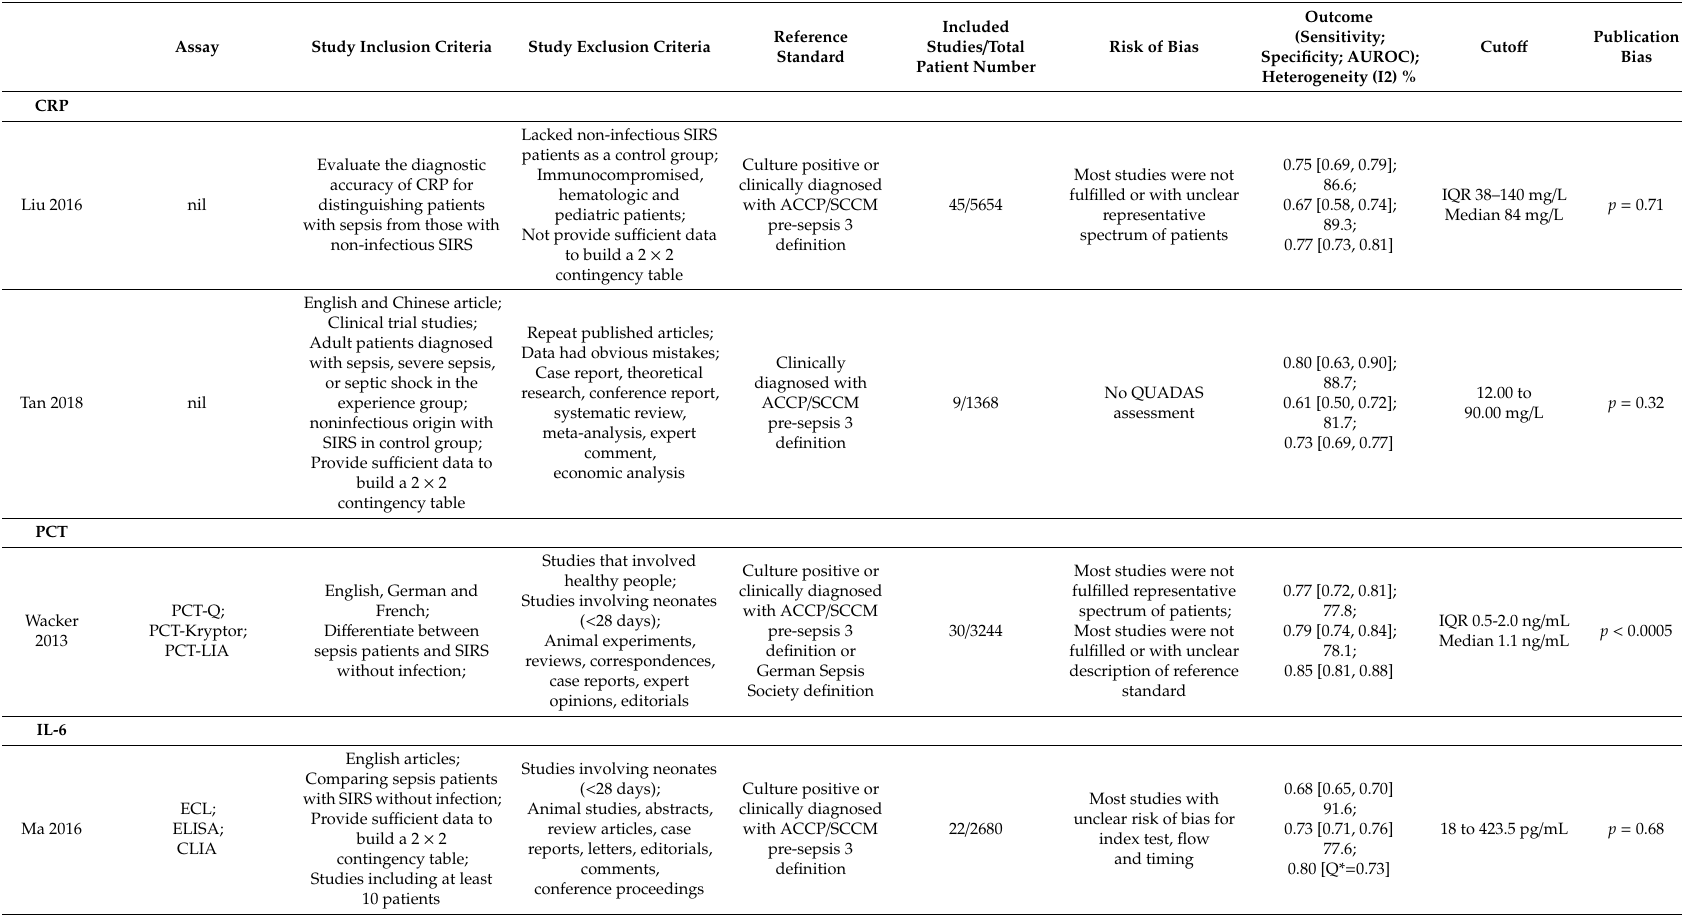
Table 1. Characteristics of enrolled systematic review and meta-analysis